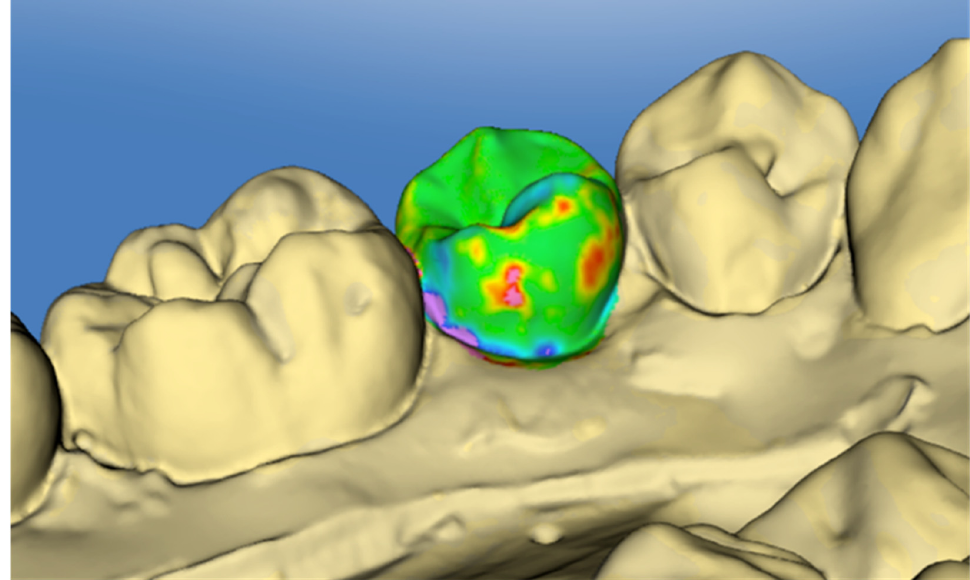
Figure 5. Superimposed 3D scans T0 and T1. Green represents unchanged areas; substance loss is indicated by blue and violet, excess material by yellow, red, and pink.